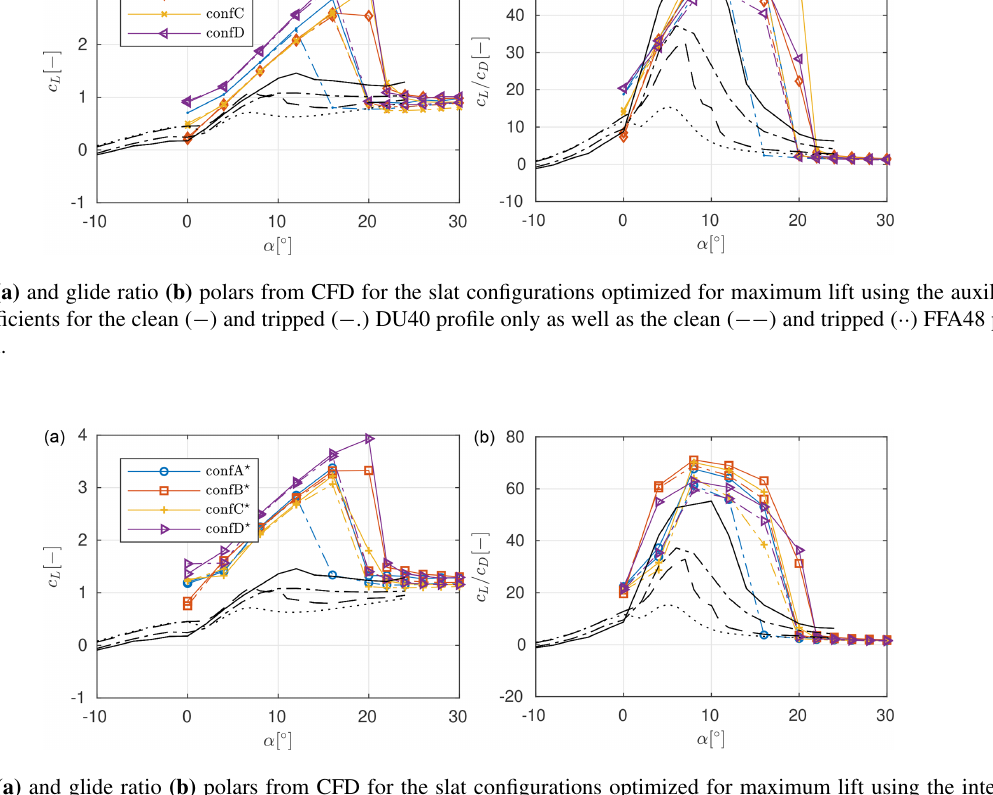
Figure A2. Lift (a) and glide ratio (b) polars from CFD for the slat configurations optimized for maximum lift using the integral design strategy; the coefficients for the clean ( − ) and tripped ( − . ) DU40 profile only as well as the clean ( −− ) and tripped ( ·· ) FFA48 profile only are shown as